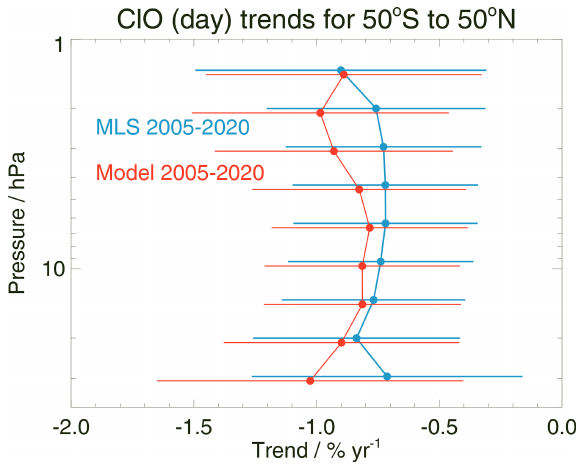
Figure 5. Trends in ClO (daytime values) over 2005 through 2020 from MLS (blue) and model (red) for the 50 ◦ S to 50 ◦ N latitude range. Error bars depict the uncertainties (2 σ ) for these trend re- sults, based on block bootstrap analyses of the monthly residual se- ries from the fits to the MLS and model time